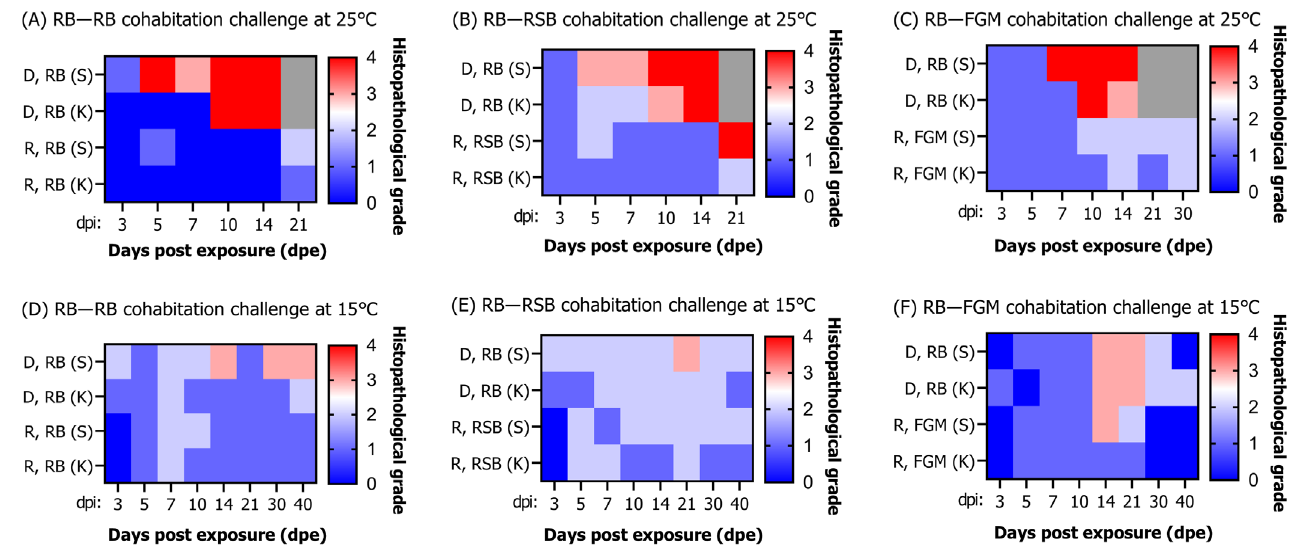
Figure 9. ( A – F ) Histopathological grade was evaluated following cohabitation challenges involving naïve rock bream ( Oplegnathus fasciatus ), red sea bream ( Pagrus major ), and flathead grey mullet ( Mugil cephalus ) (recipient, R) after intraperitoneal injection of red sea bream iridovirus (RSIV) into rock bream (donor, D) at 25 °C and 15 °C. The box indicates the average histopathological grade of the spleen (S) and kidney (K) collected from three fish. The gray box indicates that analysis could not be performed because all fish died due to RSIV infection.